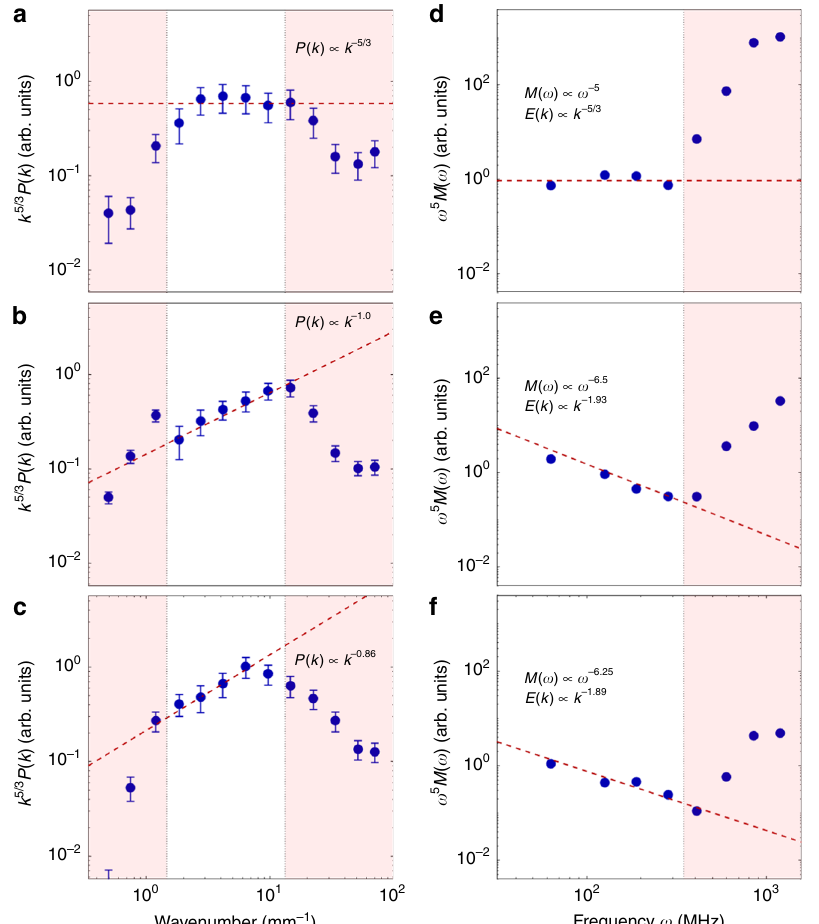
Fig. 3 Density and velocity power spectra. The blue dots in panels ( a – c ) show the measured density power spectra at 500 ns, 600 ns, and 700 ns, respectively, obtained from the corresponding Schlieren images. The dashed line shows a fi tted slope of the power spectrum, while the shaded regions mark the resolution limit of the imaging system (upper bound on wave numbers) and the size of the windowing function applied during the calculation (lower bound on wave numbers). The error bars show the standard deviation in the spectra based on measurements performed in four regions of the plasma — see box in Fig. 2b. The blue dots in panels ( d – f ) show the magnetic- fi eld power spectra taken at 500 ns, 600 ns, and 700 ns, respectively, obtained from the induction-coil data (Fig. 1). The shaded region marks the resolution limit of the induction loop. Additional details on the calculation of resolution limits and error bars are given in the supplementary